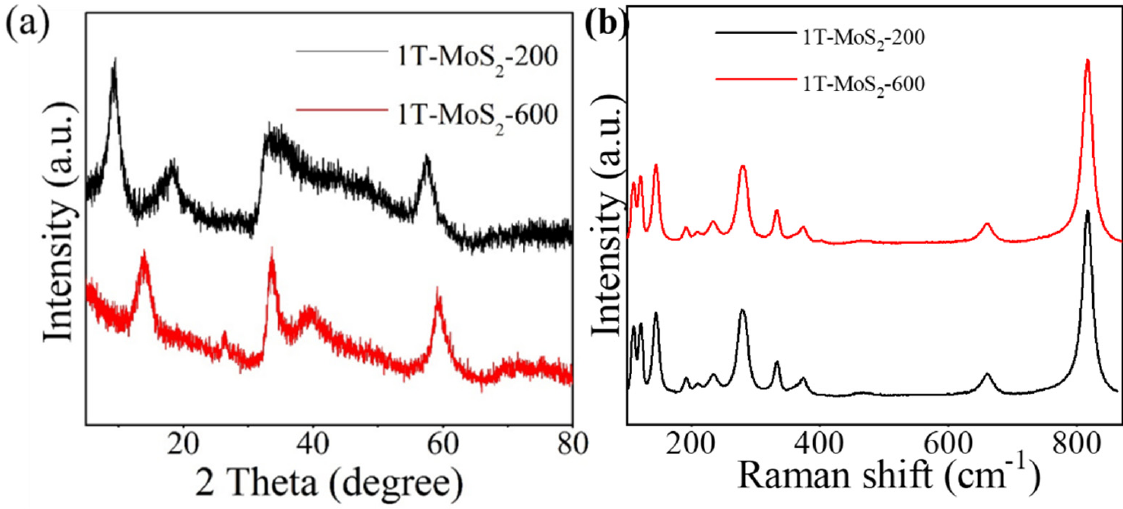
Figure 1. ( a ) XRD patterns, and ( b ) Raman spectra of 1T − MoS 2 − 200 and 1T − MoS 2 − 600, respec- tively .